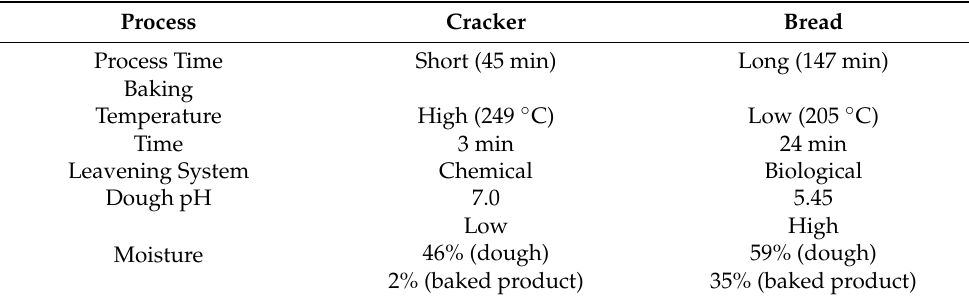
Figure 3. Total anthocyanin content (TAC, in mg anthocyanin/kg wholemeal) of bread and crackers made from AnthoGrain™ wholemeal, and wholemeal from Blue Wheats 1, 2, & 3. * indicates a significant difference between the TAC in cracker and bread products per wholemeal type. Table 7. Process parameters for the production of crackers and